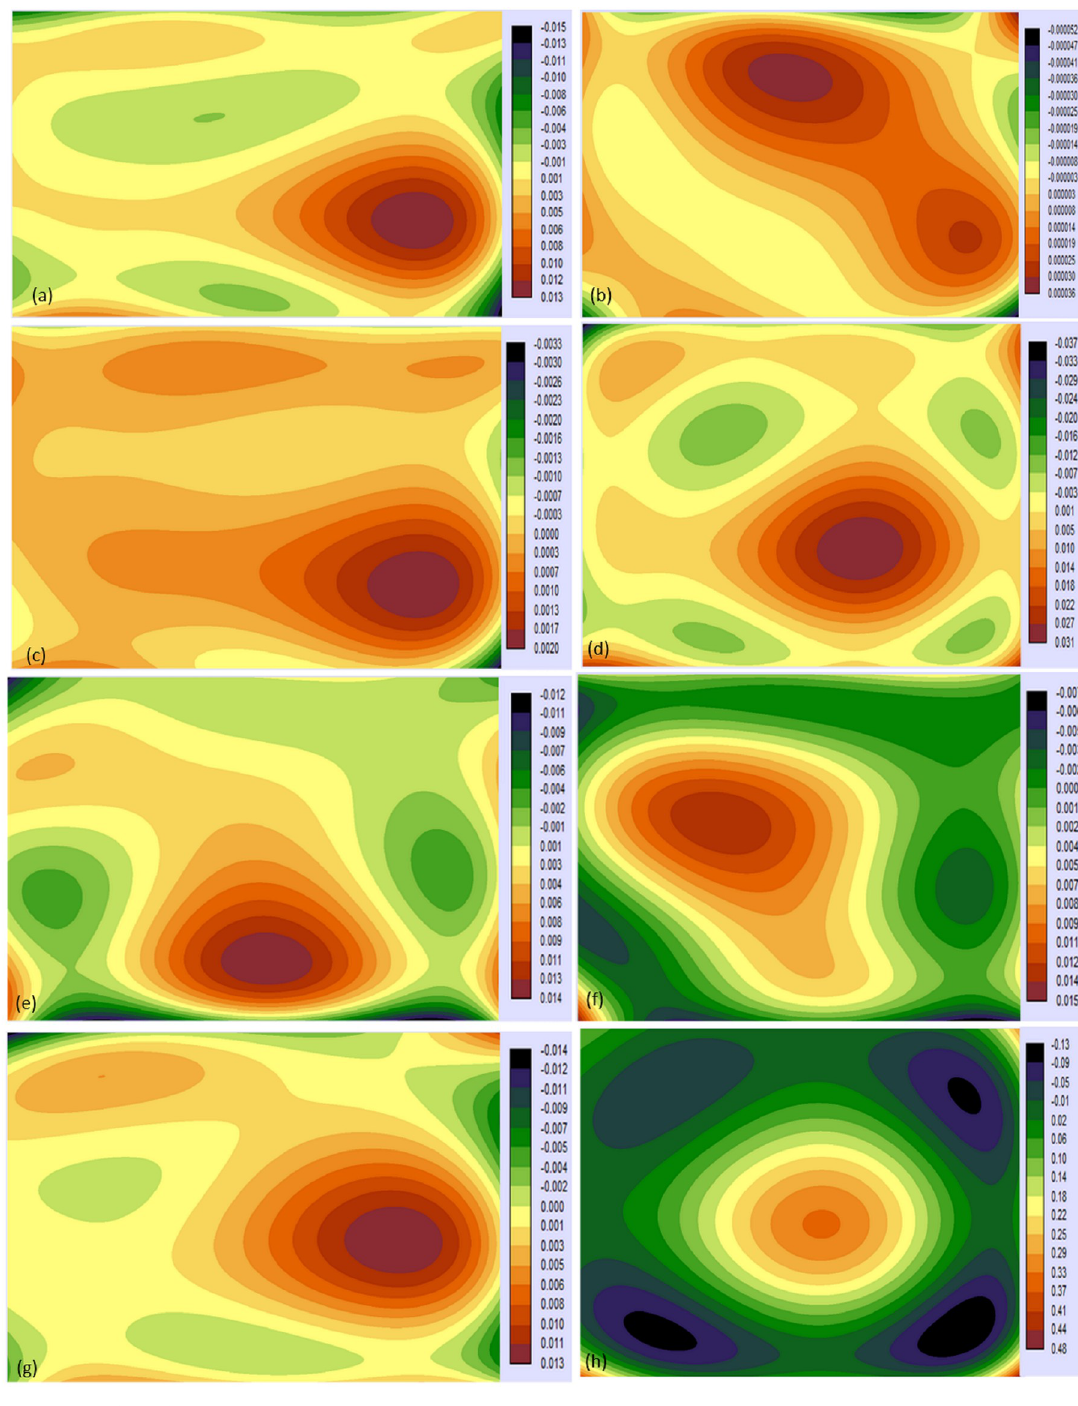
Fig 11. Spatial trend representation.